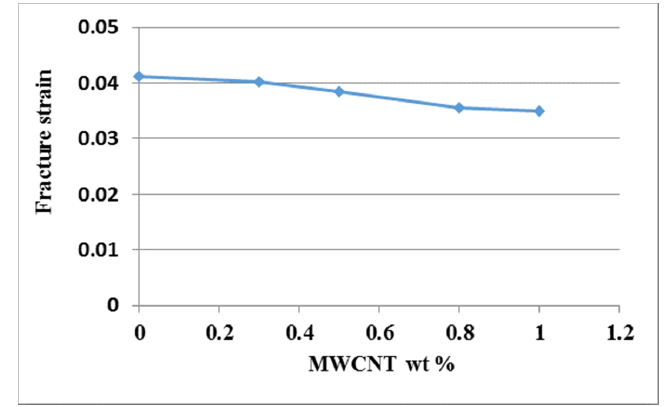
Figure 7. Fracture strain of the nanocomposite varied with different MWCNT loadings.